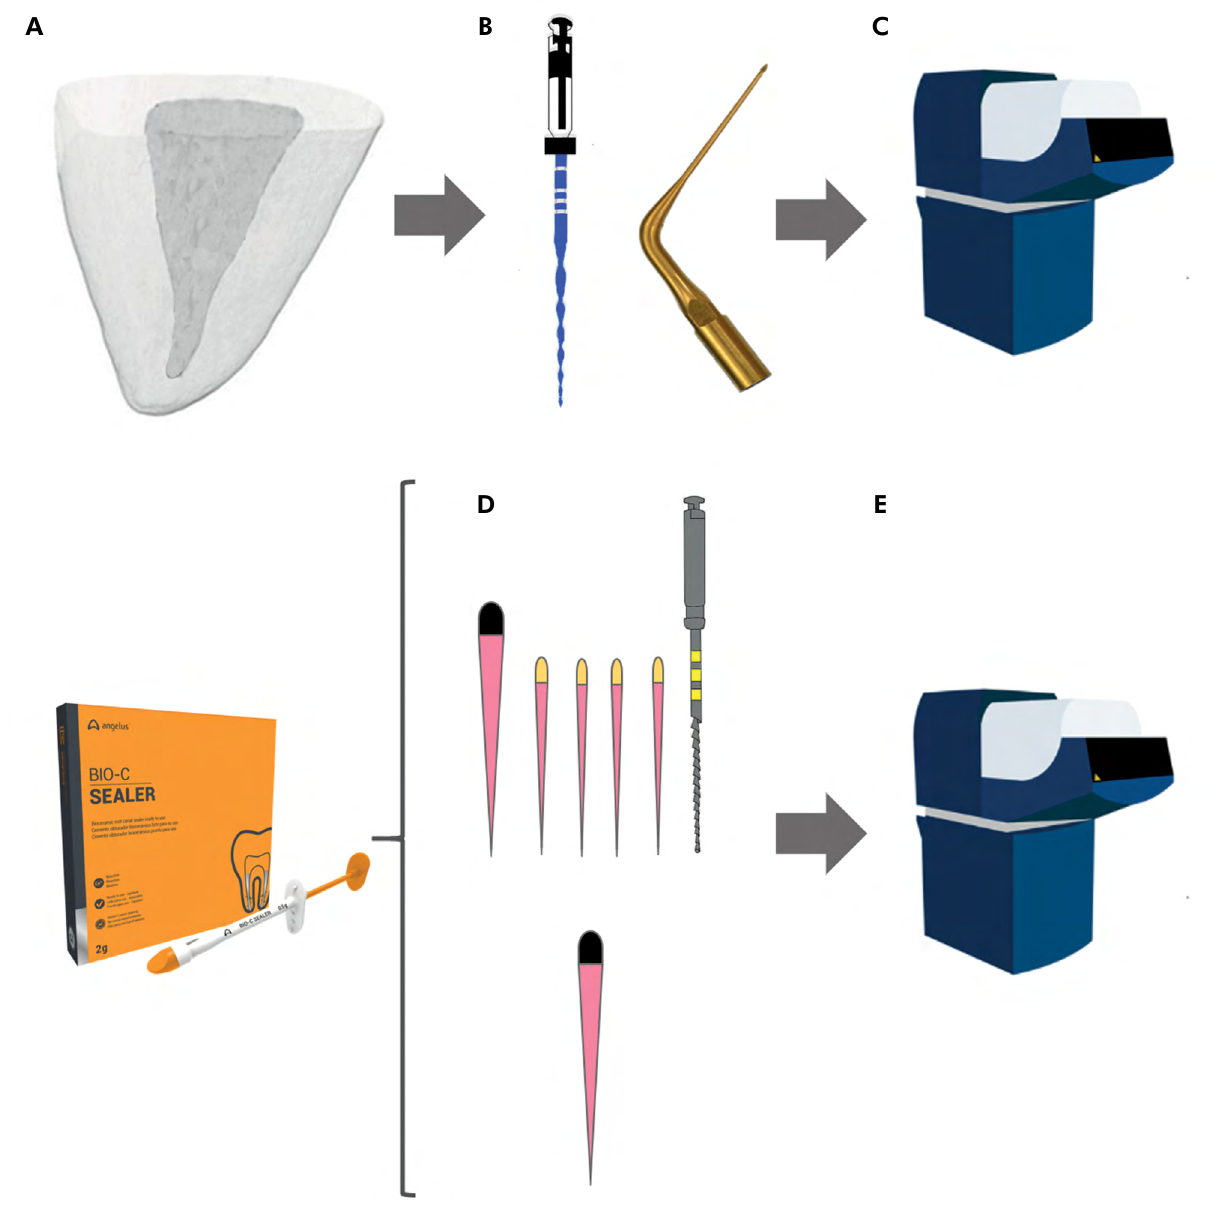
Figure 1. Schematic figure representing the methodology. (a) Flattened distal root canal of a mandibular molar; (b) Root canal preparation with Reciproc Blue R40 and Flatsonic; (c) Scanning with micro-CT - 8.74 µm; (d) Root canal filling with Bio-C Sealer using thermoplastic or single-cone techniques; (e) Scanning with micro-CT - 8.74 µm to evaluate the percentage of